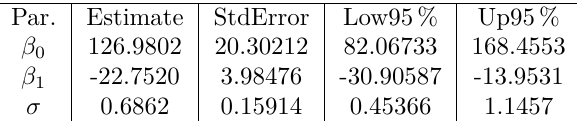
Table 1. Comparisons of the distribution of the measured data for Material#1.